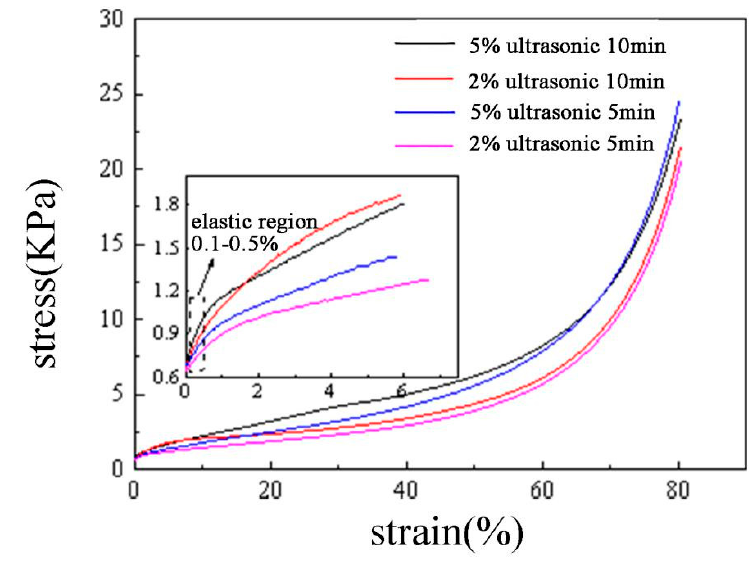
Figure 10. Stress-strain curve.